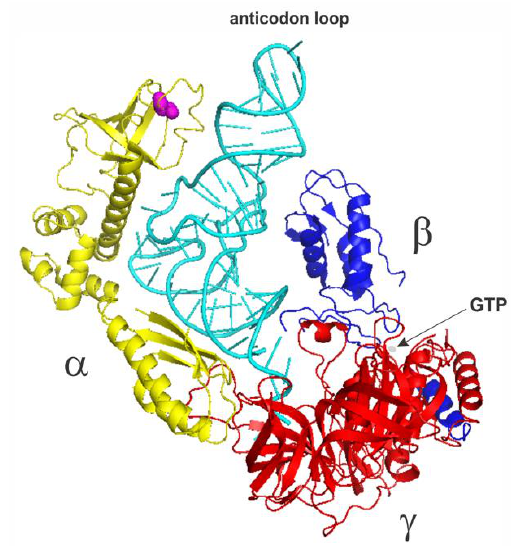
Figure 2. The structural model of the yeast eIF2 • GTP • Met-tRNA i ternary complex adapted from the structure of the yeast 48S complex (PDB 3JAP [65]) with the 40S ribosome and other factors omitted. The eIF2 α subunit is in yellow (Ser51 is in magenta; Van der Waals radii of the side chain atoms are shown), the eIF2 β subunit is in blue and the eIF2 γ subunit is in red. Met-tRNA i is in cyan. Arrow points to GTP (in gray).